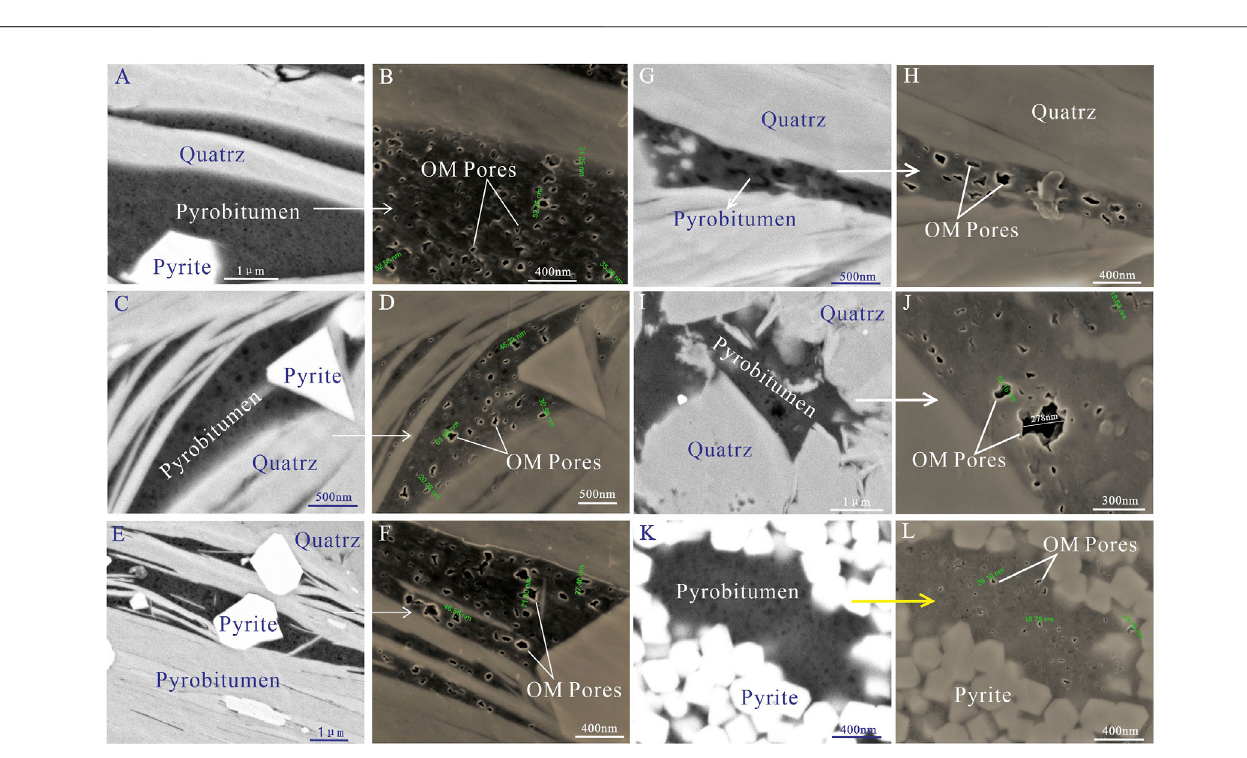
Frontiers in Earth Science |